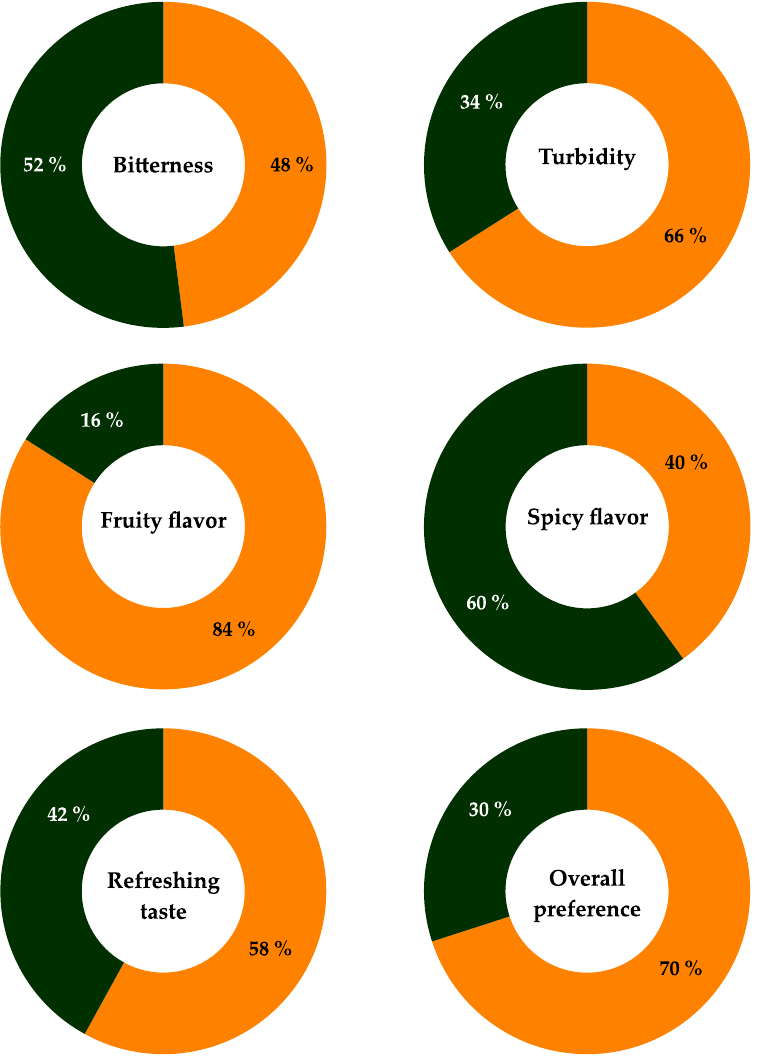
Figure 4. A comparative analysis of various attributes of two Belgian-style pale ales: the product herein elaborated with P. kudriavzevii 4A ( (cid:4) ) and a commercial reference sample made with S. cerevisiae ( (cid:4) ).